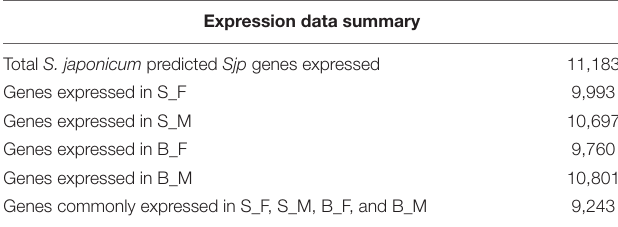
TABLE 2 | Gene expression in Schistosoma japonicum female and male worms recovered from SCID and BALB/c mice, respectively, as detected by RNA-seq. Expression data